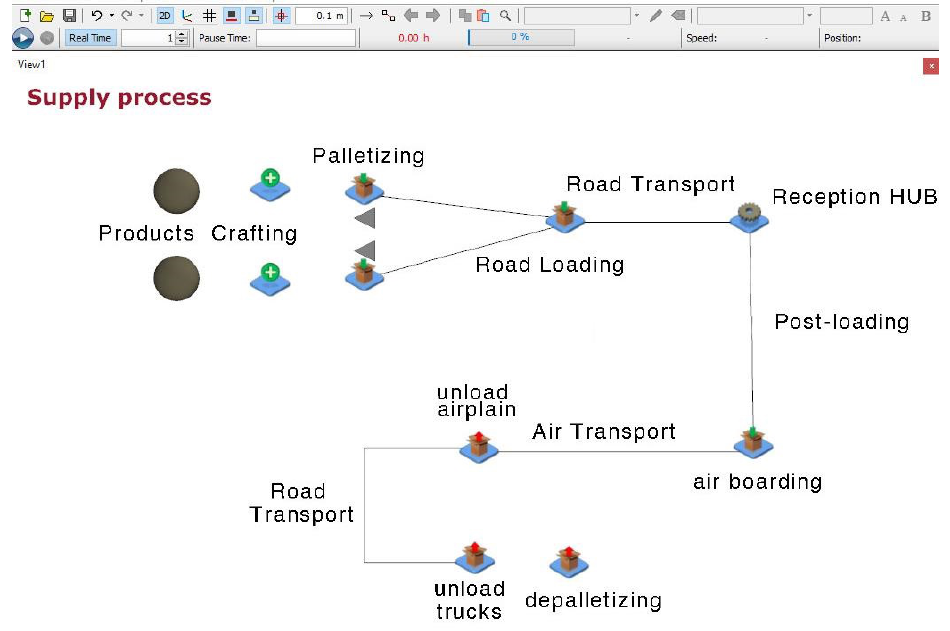
Figure 13. JaamSim supply delivery process.